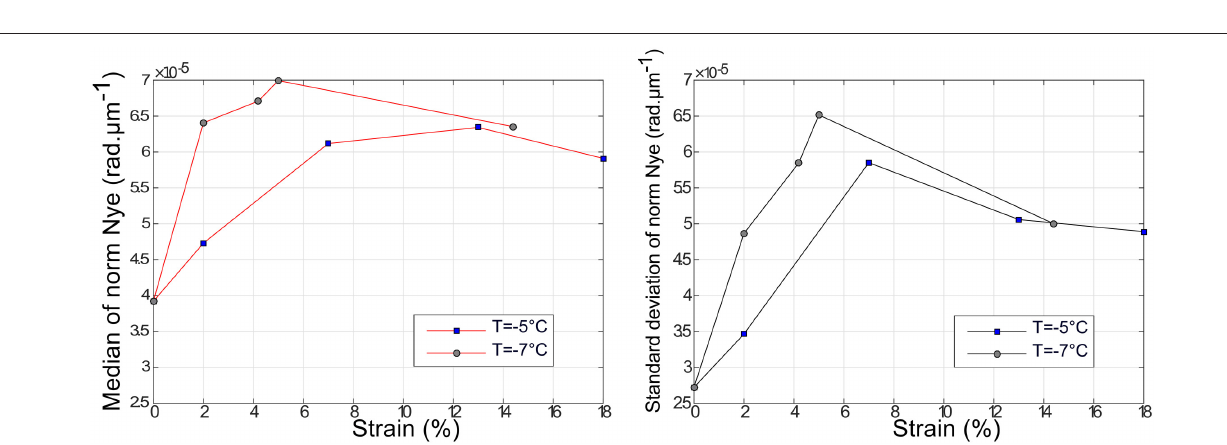
FIGURE 10 | Evolution with deformation of averaged observable norm of the Nye tensor (rad. µ m − 1 ) and its standard deviation, for the two temperature